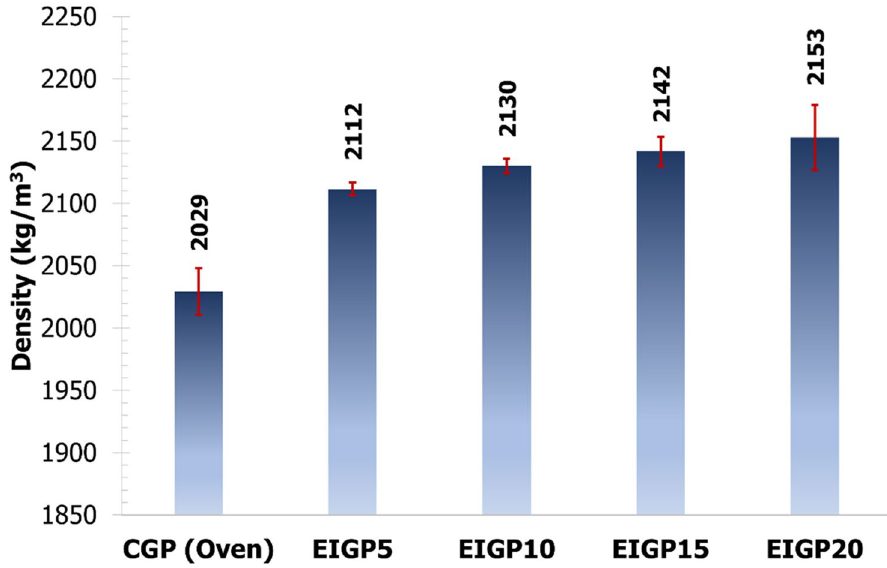
Figure 4. The densities of CGP and EIGPx samples at 28 days.